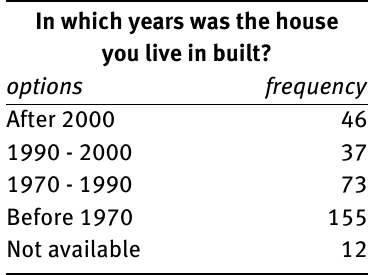
Table 7: Frequency distribution of the year of subjects’ dwelling construction